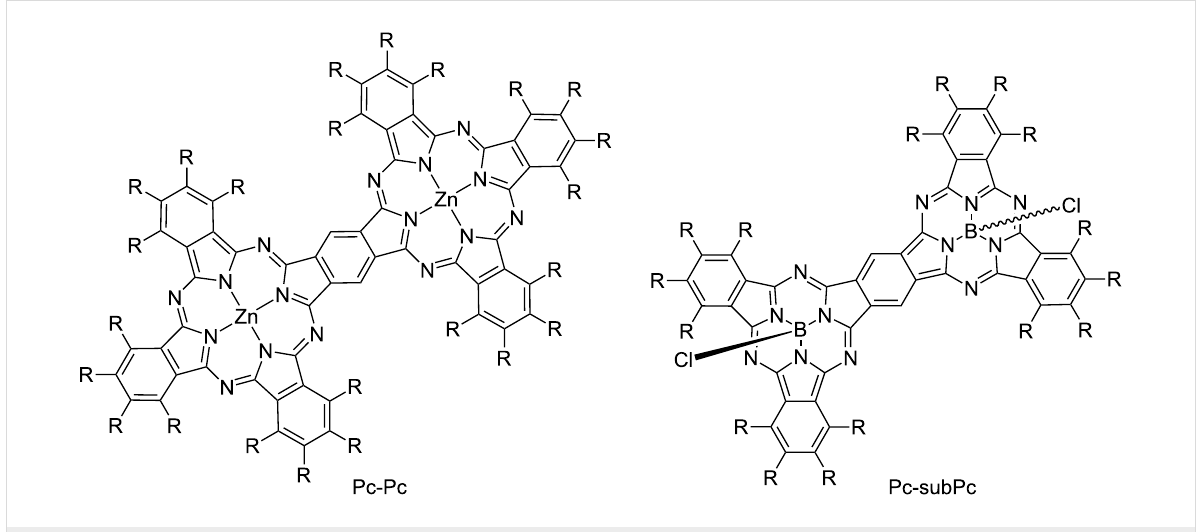
Figure 9: Structure of phthalocyanine and subphthalocyanine benzene-fused homodimers.